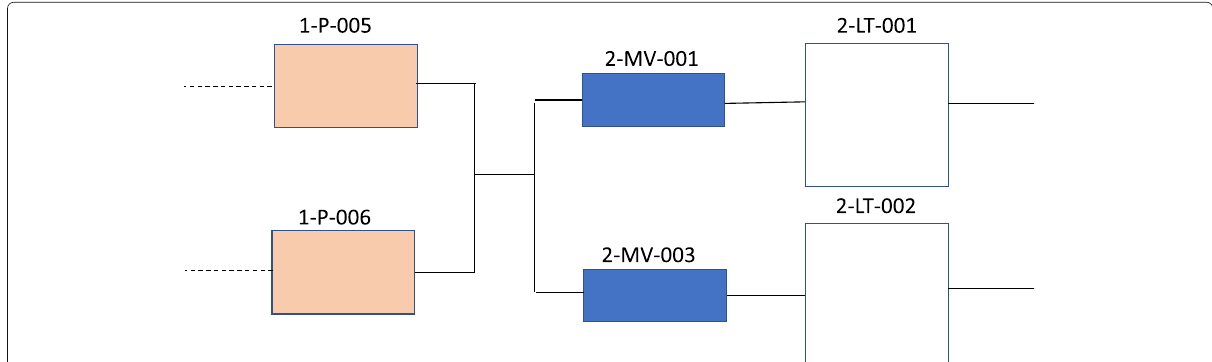
Fig. 13 Attacks #11-#13 on WADI: including SAOS and MAOS